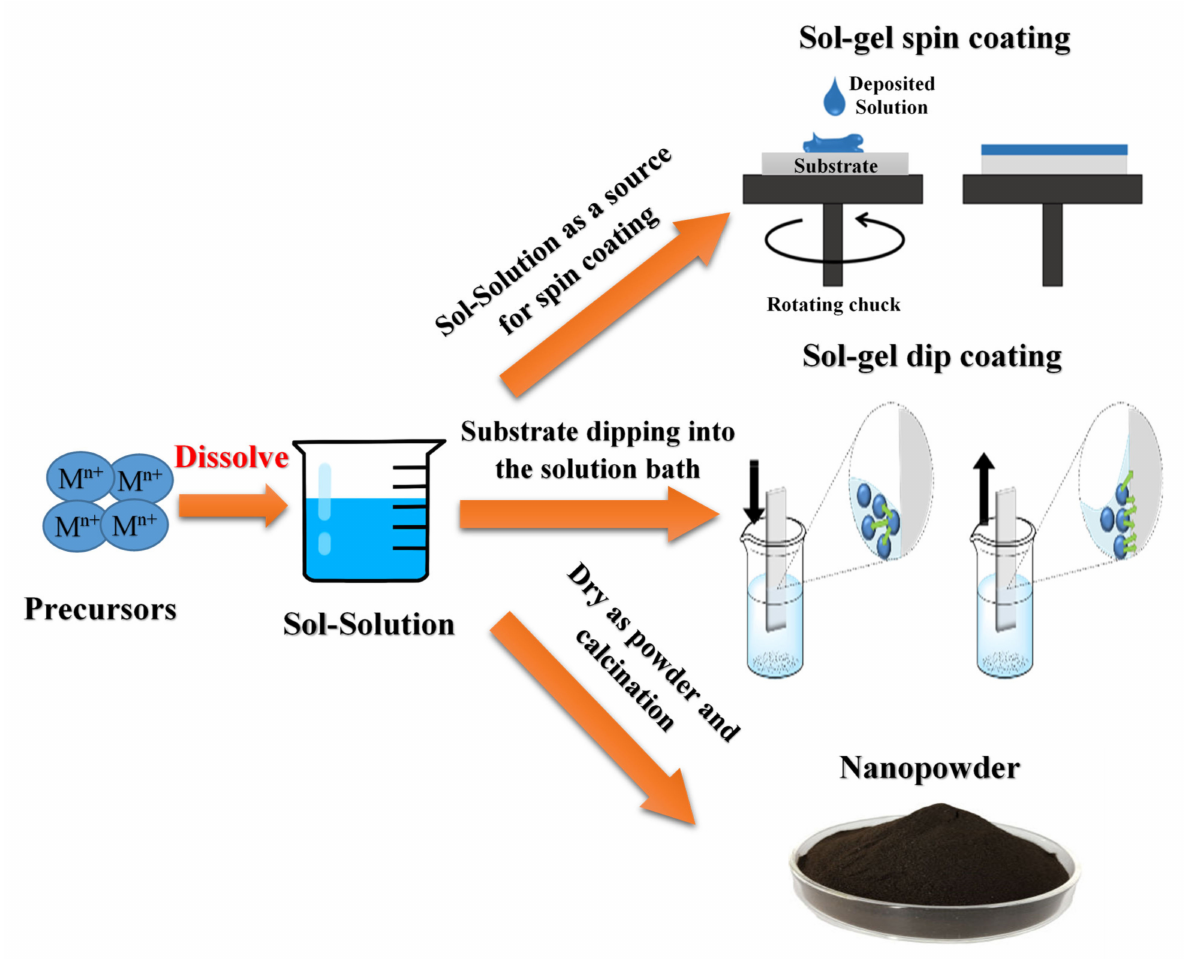
Figure 2. The representative diagram of the sol-gel technique, modified with permission from Ref. [29], IntechOpen, 2017.